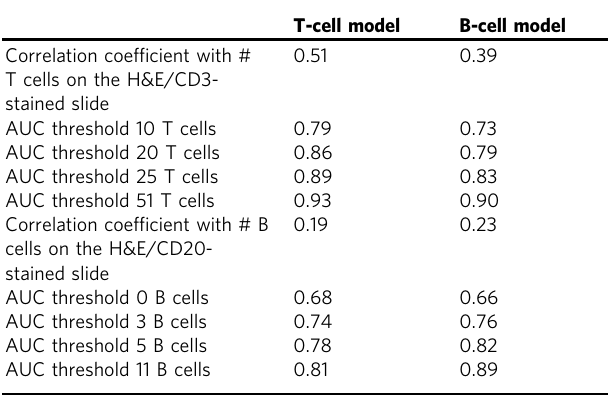
Table 2 Comparison of per-tile predictions of the T- and B-cell model to the real number of T and B